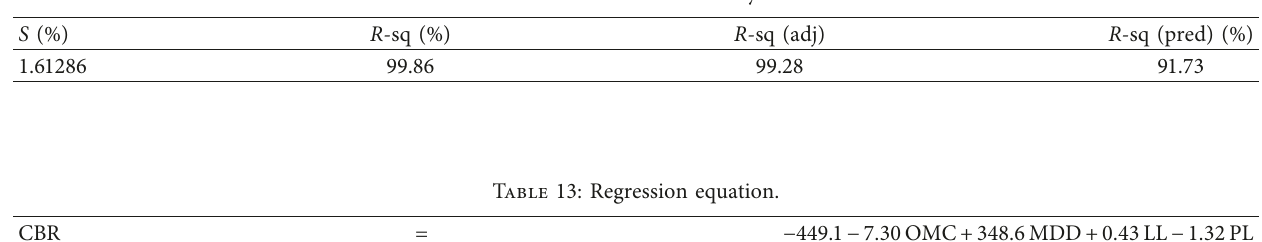
Table 13: Regression